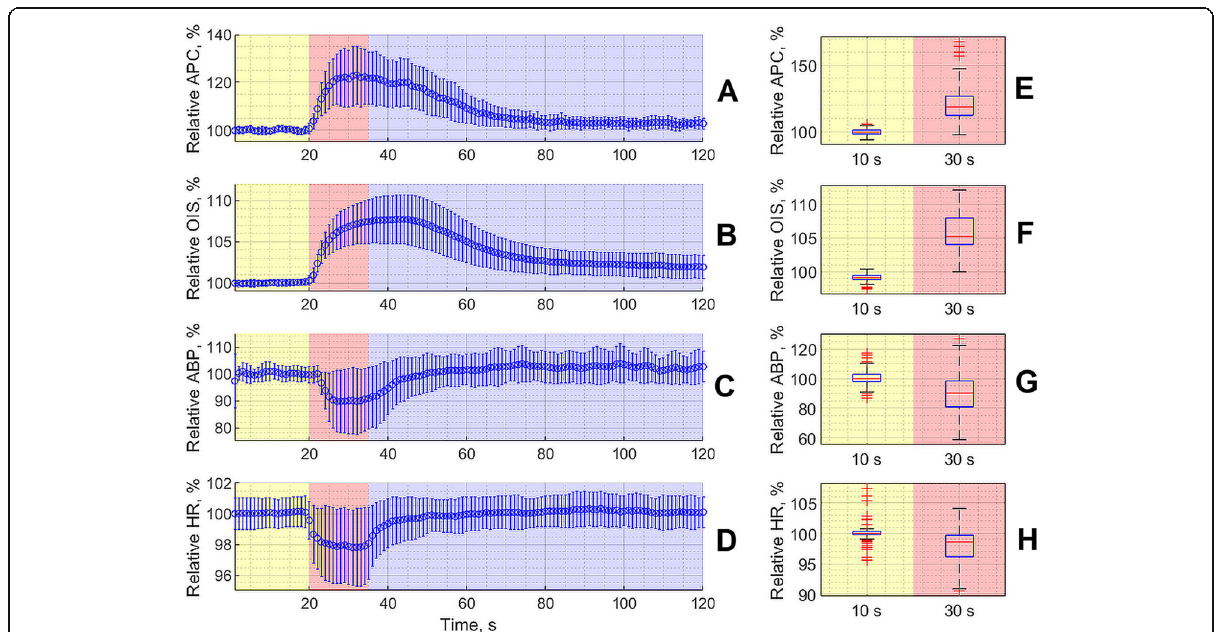
Fig. 3 Relative change of the parameters measured in a contactless way by the digital camera (APC, graph a , and OIS, graph b ) and invasively (ABP, graph c , and HR, graph d ) in response to the CCW electrical stimulation. Here we show the data averaged over 96 baseline measurements carried out in three subsequent trials with three groups of animals before pharmacological interventions. Curves in the graphs show evolution of the mean value while the whiskers are the standard deviations. Yellow color indicates the pre-stimulation phase, the red one marks a 15-seconds period of the electrical stimulation, and the violet is the relaxation phase. Right-side panels ( e , f , g and h ) illustrate the statistical significance of the respective hemodynamic parameter assessed at the 10th s of the trial (pre-stimulation phase) and at the 30th s of the trial (stimulation